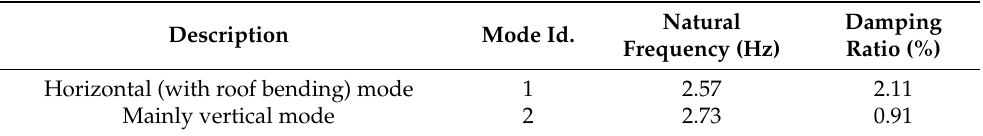
Table 2. Identified modes of the entire pavilion.